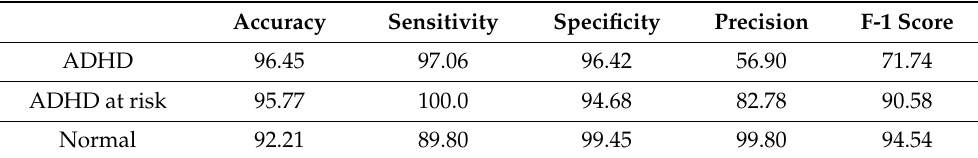
Table 12. The performance of the screening diagnostic tool using a robot (%). Accuracy